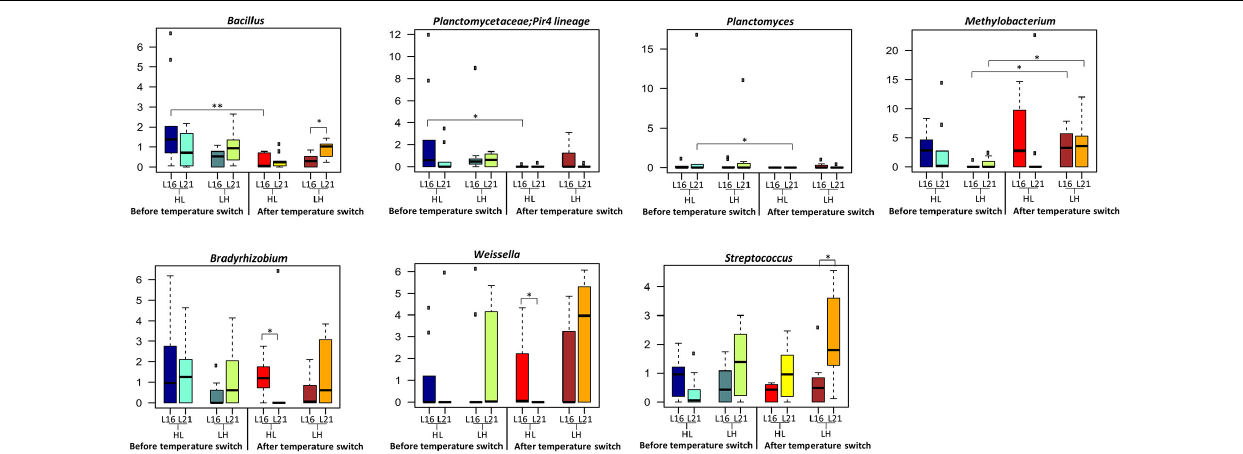
FIGURE 5 | Taxonomic composition of bacterial communities of distal gut content of gilthead sea bream fed with the experimental diets and exposed to temperature switch over 121 days. Distributions of relative abundance of genera that showed a significant variation between groups fed with different diets or after the temperature switch (Wilcoxon rank-sum test, ** p ≤ 0.01; * p ≤ 0.05), only genera with a mean relative abundance ≥ 1.0% in at least one group were represented. The central box of each dataset represents the distance between the 25th and the 75th percentiles. The median between them is marked with a black line. L16, low-lipid 16% diet; L21, high-lipid 21% diet; HL, constant temperature exposure to high (H) temperature of 23 ◦ C before, and to low (L) temperature of 17 ◦ C after, temperature switch; LH, constant temperature exposure to low (L) temperature of 17 ◦ C before, and to high (H) temperature of 23 ◦ C after, temperature switch. Temperature switch occurred on day